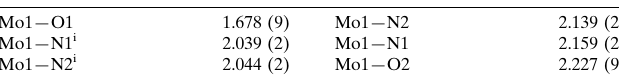
Selected bond lengths (A˚